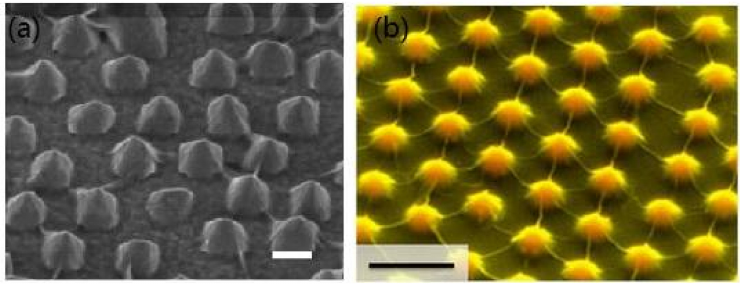
Figure 3. ( a ) Graphene-coated Au nanopyramid structure. Scale bare is 200 nm. Reproduced from [30] with permission; Copyright ACS 2015. ( b ) Tilted false-colour SEM image of the 2D strained MoS 2 crystal defined by the nanocone array. Scale bar is 500nm. Reproduced from [59] with permission; Copyright Springer